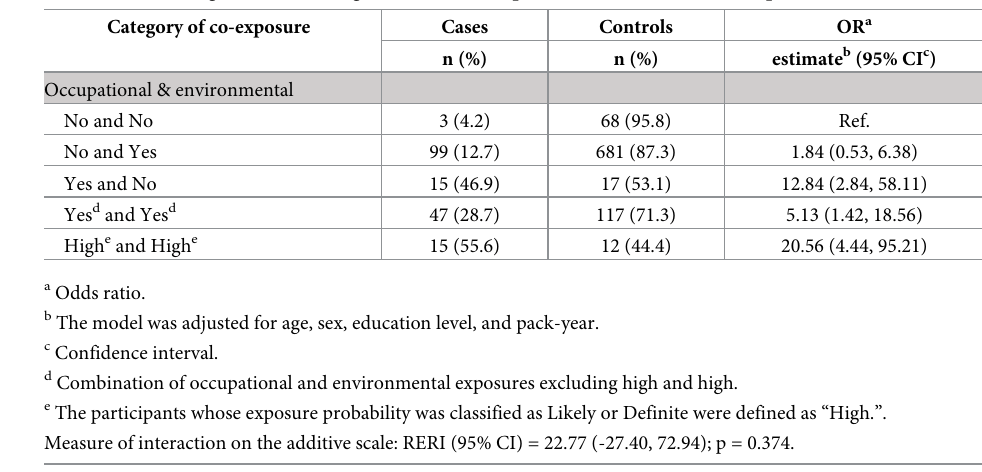
Table 5. Risk of lung cancer according to combined occupational and environmental exposure to